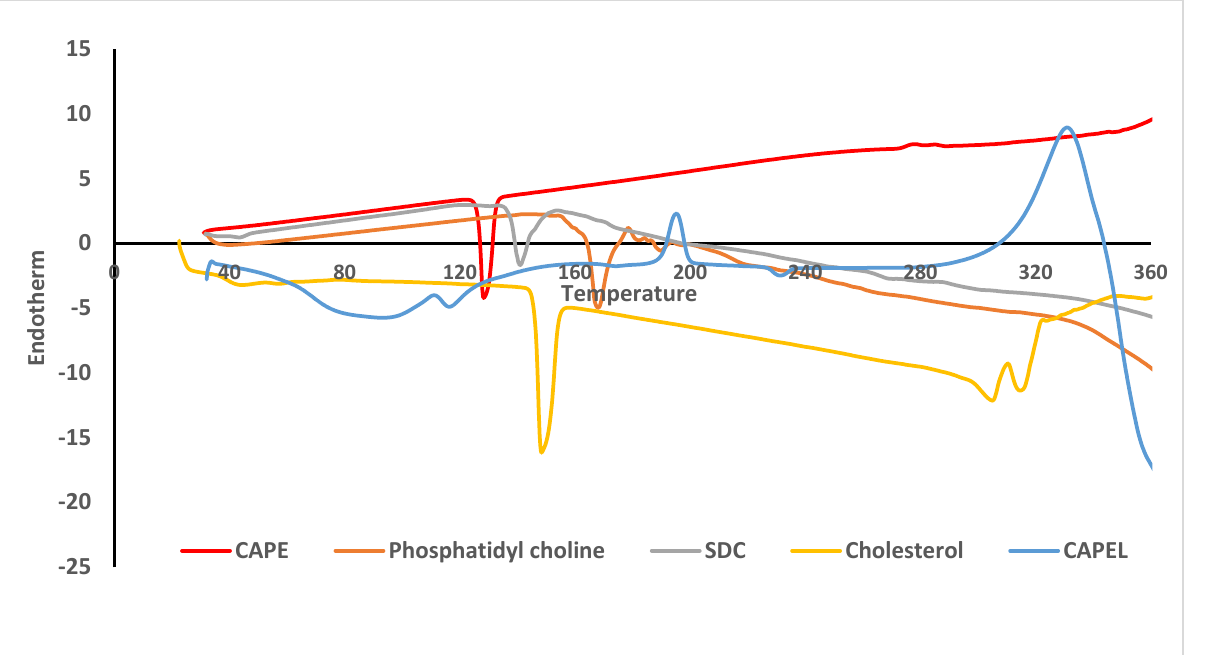
Figure 2. Morphology and size of caffeic acid phenethyl ester (CAPE)-optimal liposomal formula- tion (CAPEL) using transmission electron microscope (TEM) ( n = 1).